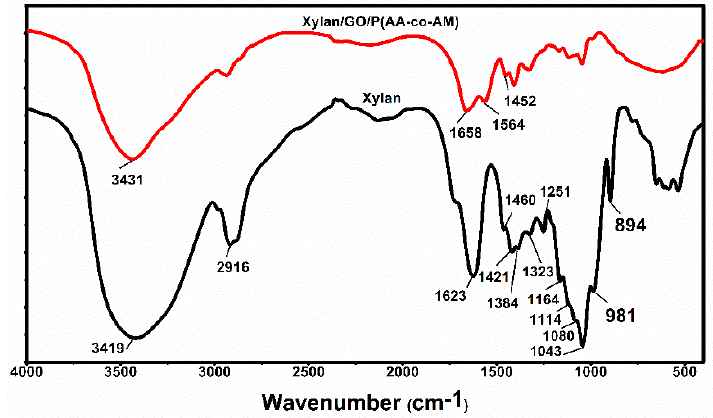
Figure 2. FTIR spectra of xylan and prepared hydrogels.